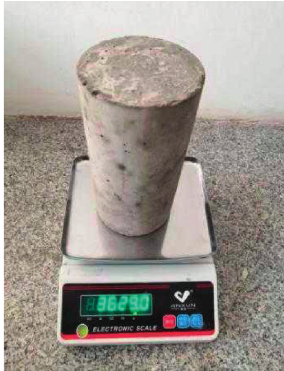
Figure 5: Measuring the mass of the